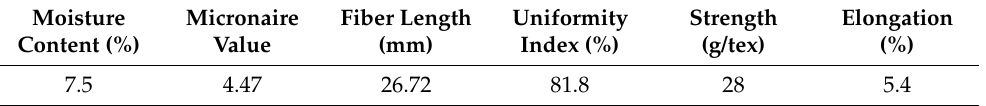
Table 1. Properties of cotton fibers.